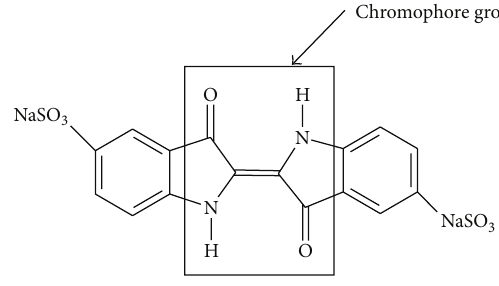
Figure 1: Chemical structure of